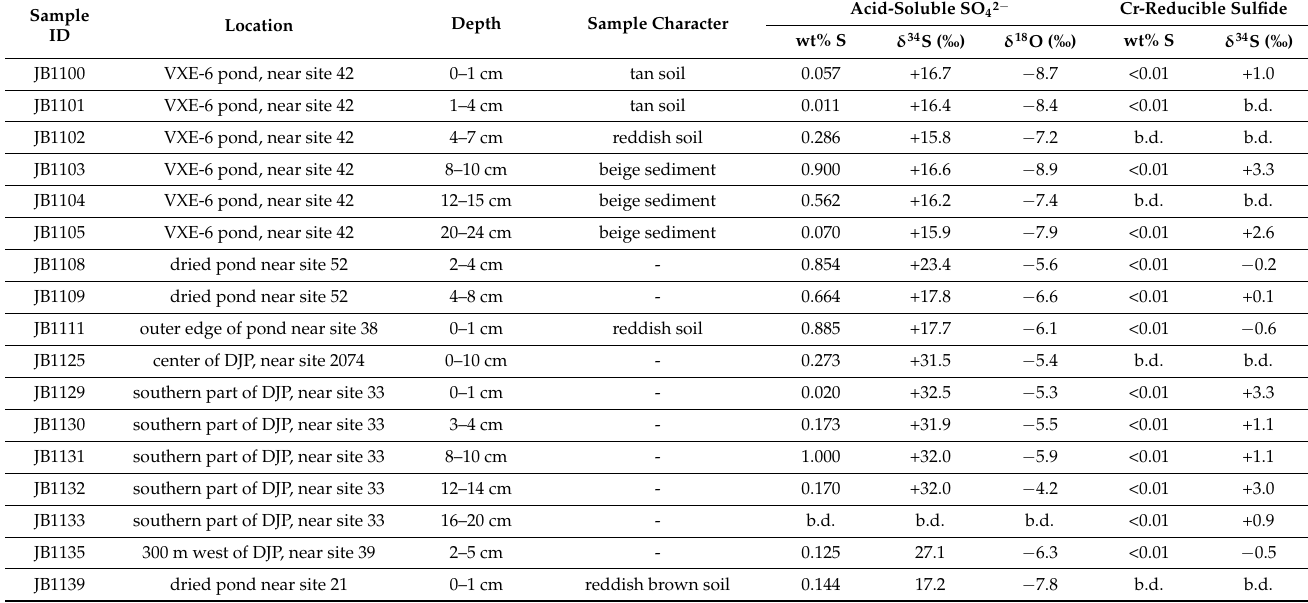
Table 1. Description of sediment and soil samples from South Fork of Wright Valley, Antarctica and their isotope composi- tions of sulfur-bearing mineral phases determined using the sulfur sequential extraction method. b.d.–below